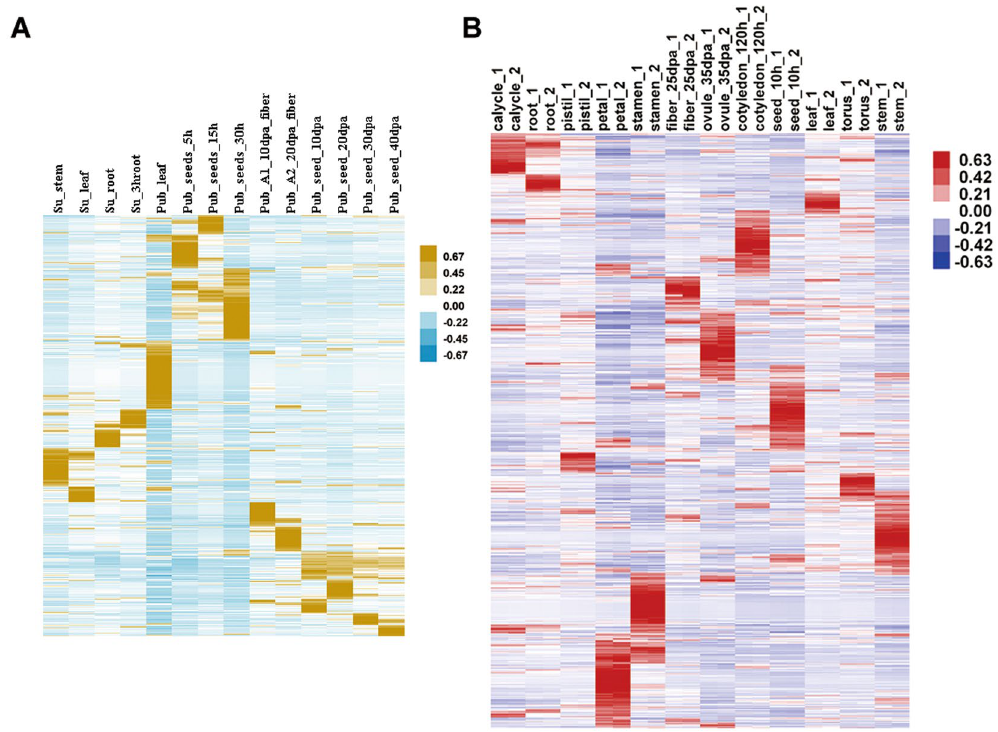
Figure 7. Differential expression situation of novel transcripts. ( A ) Heatmap clustering of newly identified transcripts in G. arboreum among 14 expression profiles of six different tissues, including stem, root and leaf, fibre, seed and seedlings The “Su” stands for in-house data, and the “Pub” stands for public data. Each coloured box indicates the z-score. ( B ) Heatmap clustering of newly identified transcripts in G. hirsutum among 24 expression profiles from twelve different tissues, including torus, calycle, pistil, stamen, petal, leaf, stem, root, seed, cotyledon, ovule and fibre. Each box indicates the